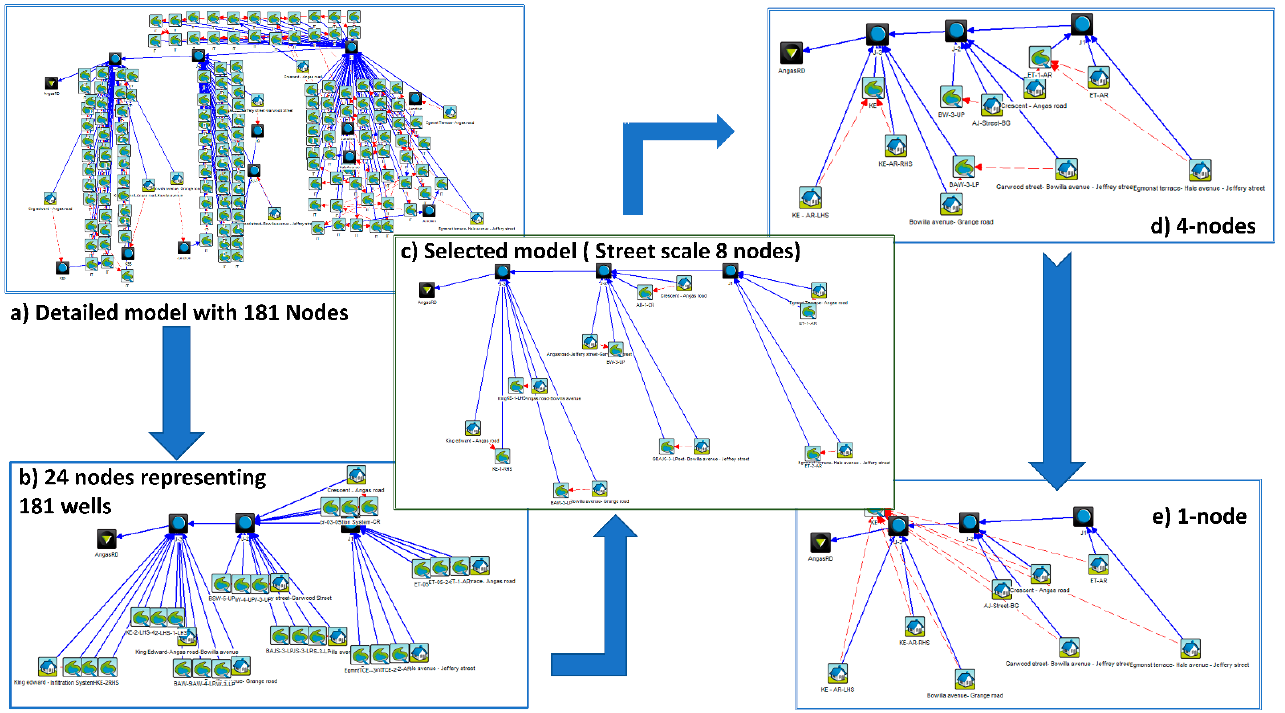
Figure 5. The graphical representations of aggregations methodology. The selected model placed in the center of the figure.( a ) detailed model with 181 nodes ( b ) model with 24 nodes standing for 181 wells ( c ) street scale model with one node for each sub-catchment, this was selected for further analysis ( d ) model with 4 nodes standing for 181 well and ( e ) 1-node model.